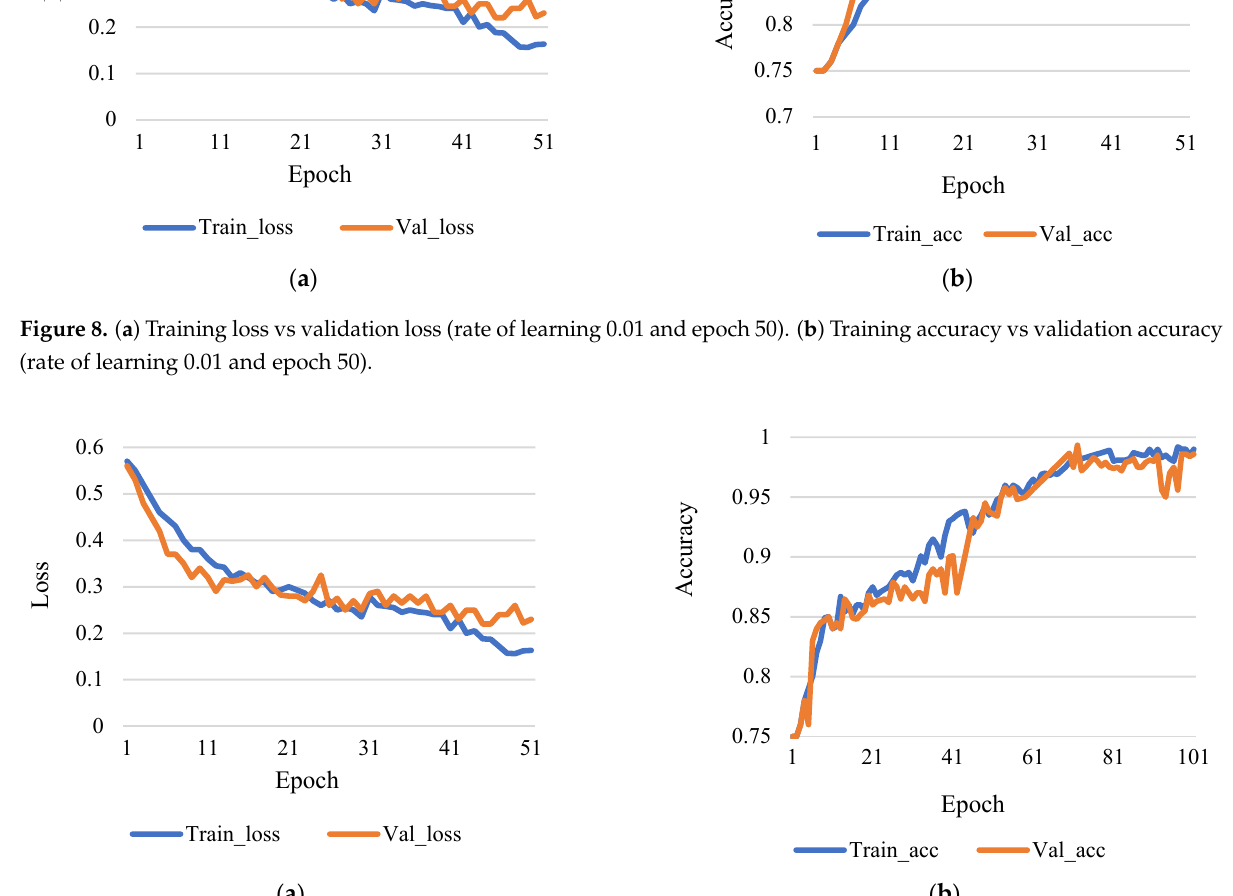
Figure 9. ( a ) Training loss vs validation loss (rate of learning 0.01 and epoch 100). ( b ) Training accuracy vs validation accuracy (rate of learning 0.01 and epoch 100).